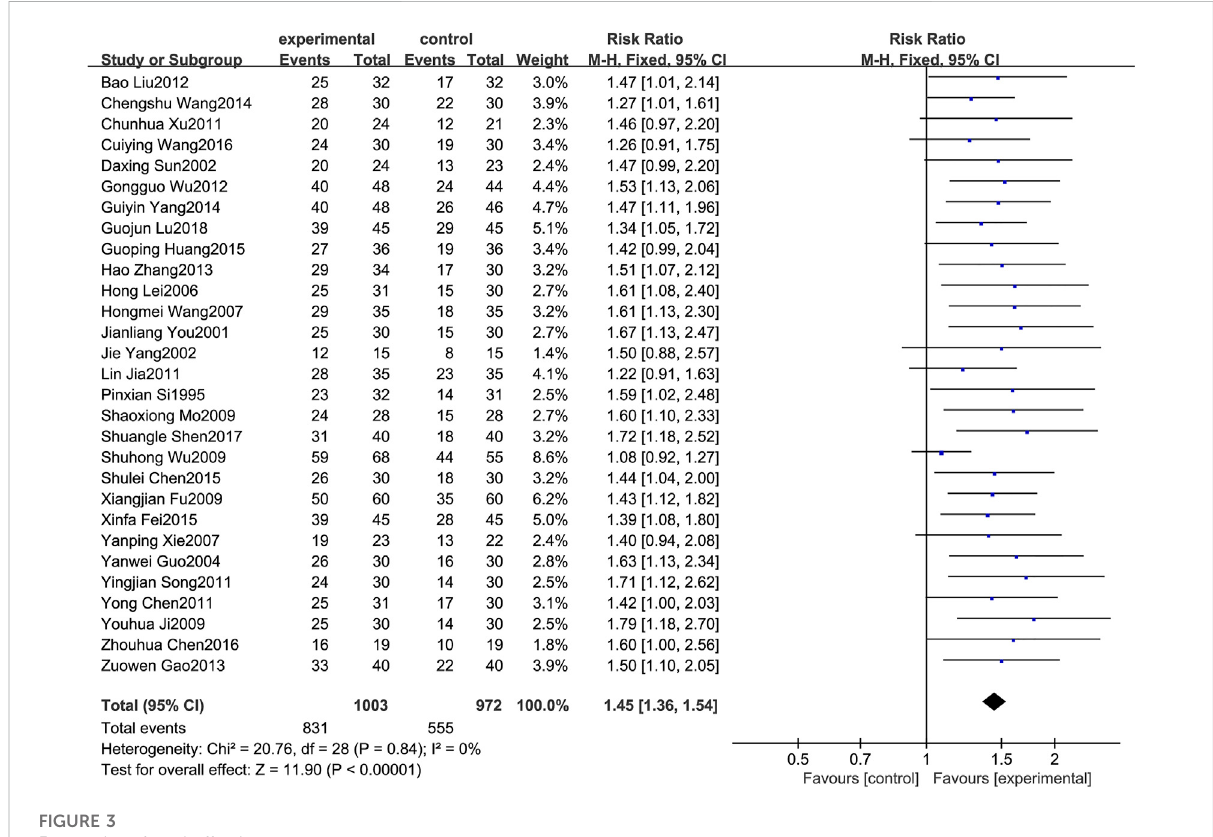
FIGURE 3 Forest plot of total effective